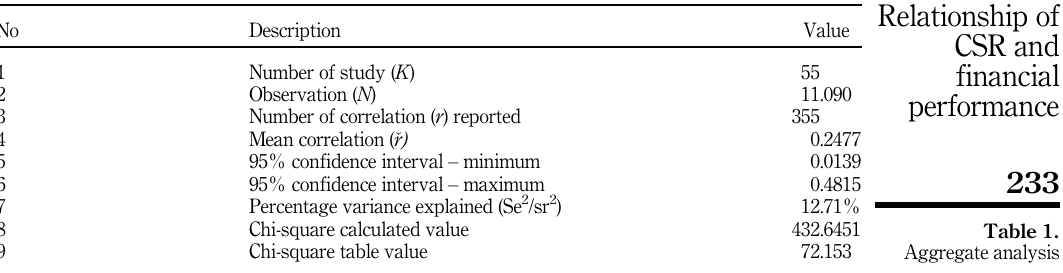
Table 1. Aggregate analysis